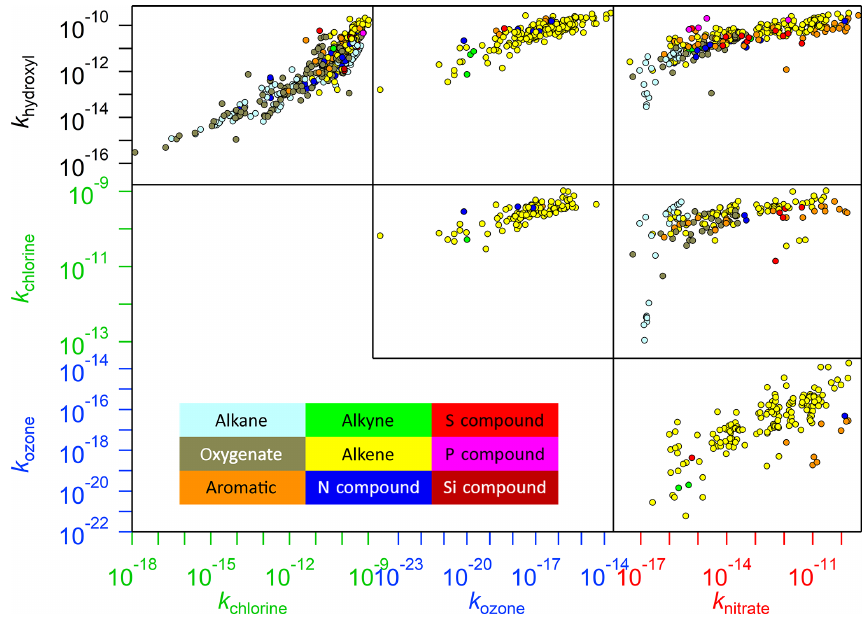
Figure 7. Plots showing correlations between the reaction rates of the various oxidants within this database. Since it is possible that a compound may belong to several of the groupings shown in the legend, categorization of these compounds has been prioritized by reactivity (e.g. an alkene that is also an oxygenate is described as an alkene, since this is likely to be the dominant reactive